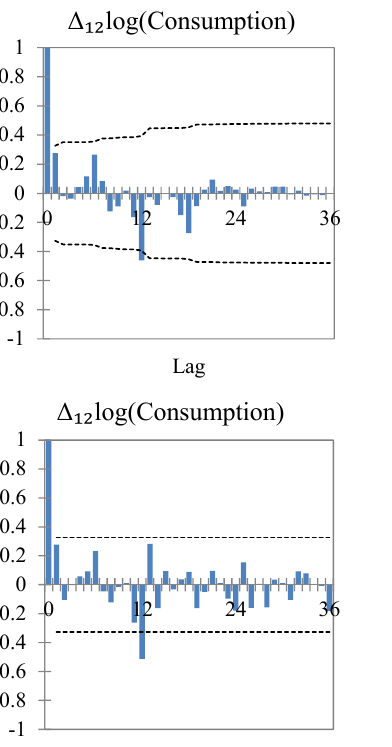
Figure 4. ACF and PACF plots of logged transformed consumption with differenced values for : ( a ) None; ( b ) Δ log; ( c ) Δ ²log; ( d ) Δ₁₂ log; ( e ) Δ₁₂ , ₁ log of consumption.